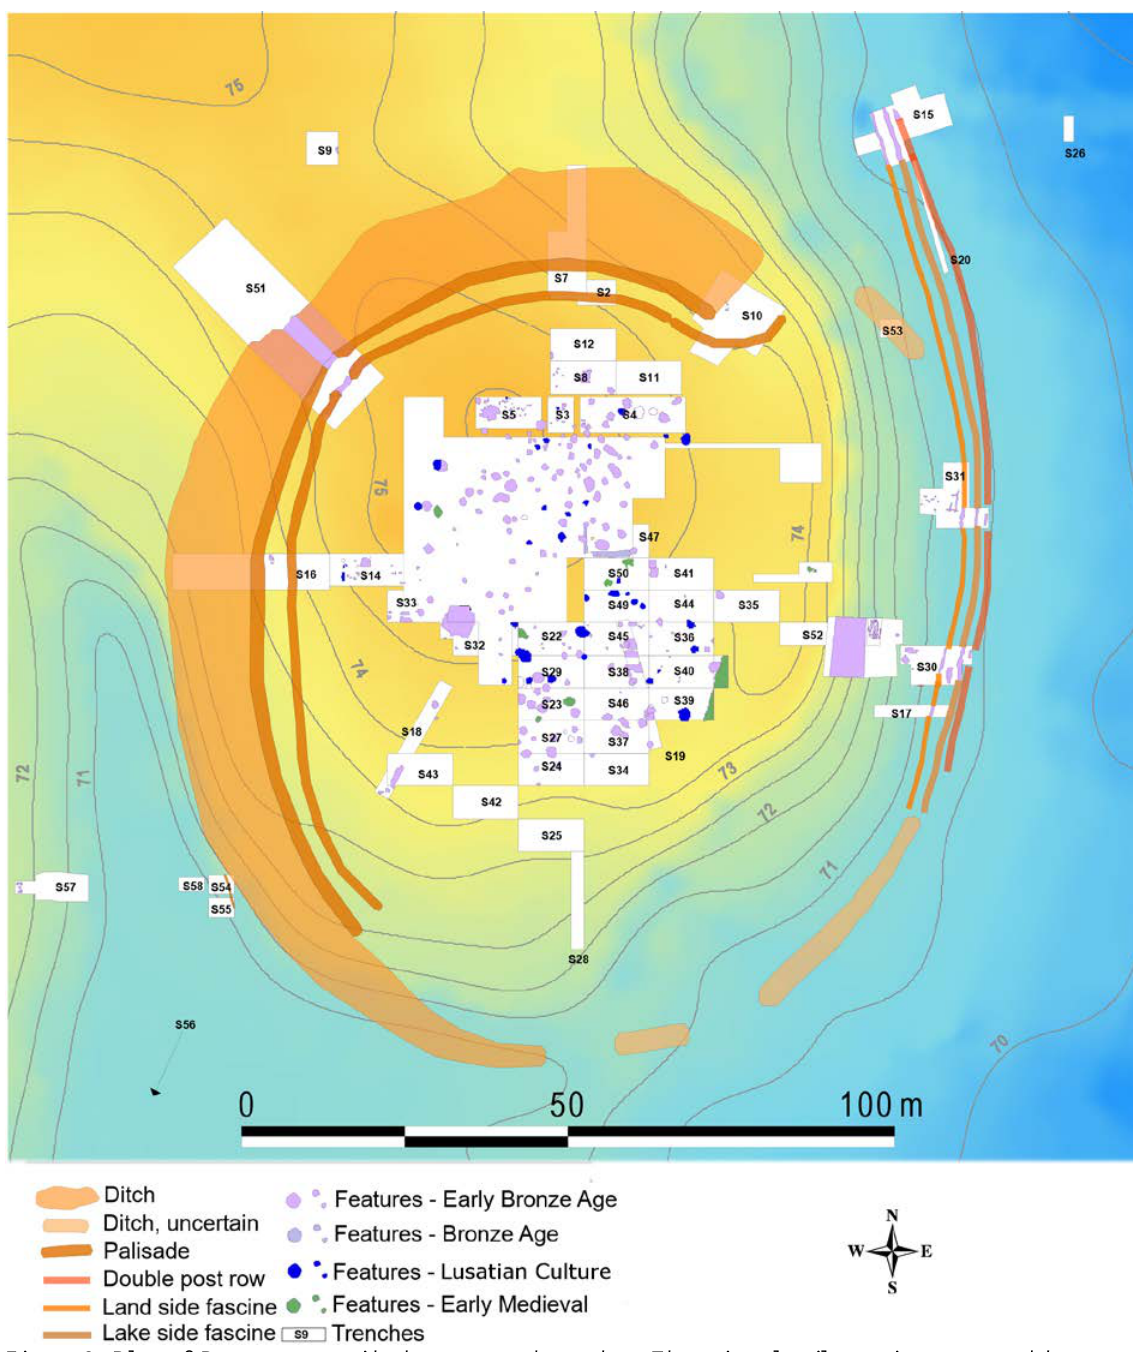
Figure 2. Plan of Bruszczewo, with the excavated trenches. The mineral soil area is represented by warm colours, while the wet soil area coincides with cold